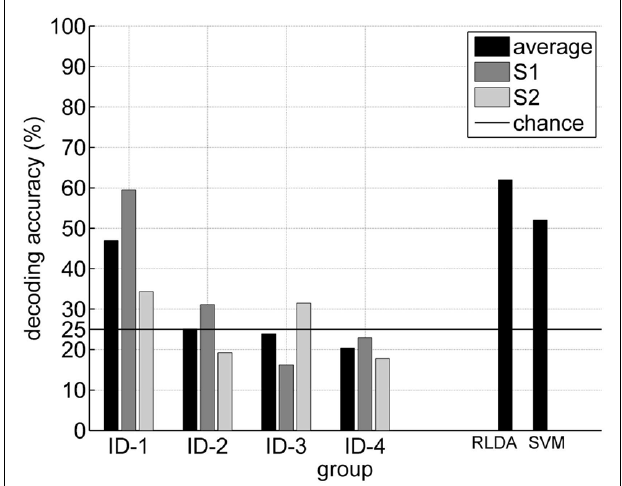
FIGURE 23 | (Data Set 3). Results of the BCI competition IV and, for comparison, the average result of applying a RLDA and linear SVM to the low-pass filtered and resampled activity of the